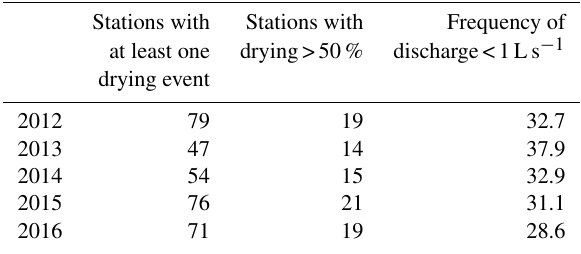
Table 1. Annual statistics on flow intermittence calculated on HY- DRO gauging stations between 1 May and 30 September. Stations with Stations with Frequency of at least